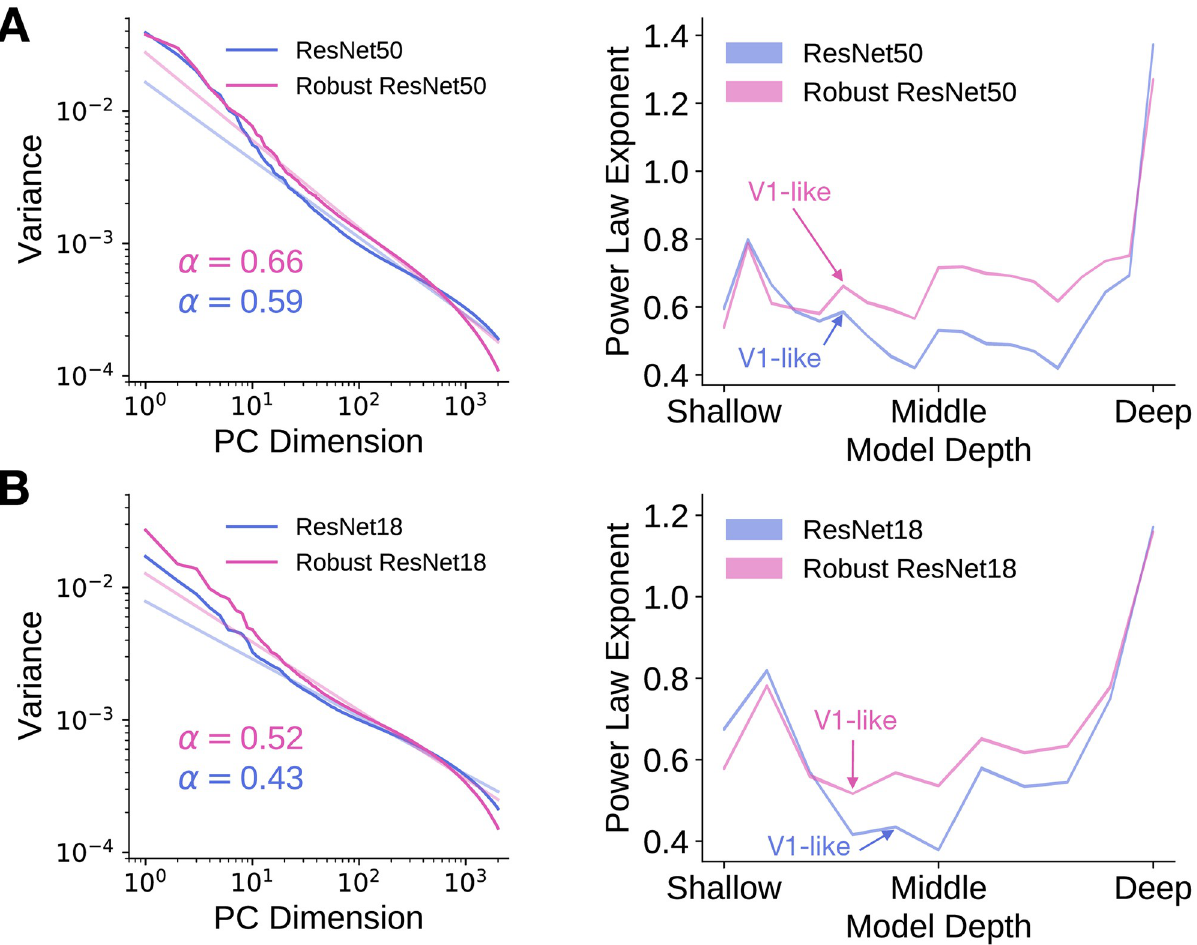
Fig 3. The internal representations of robust models is slightly lower dimensional than those of non-robust models. The eigenspectrum of the robust model decays slightly faster than that of the non-robust model. The eigenspectrum of the artificial neural responses in each layer of a model to a random subset of 2816 ImageNet validation set images was computed using principal components analysis and the power law exponent was computed by obtaining the slope of the line of best fit to the variances within the principal component range of 10 and 999. Changing the range of variances used to compute the power law exponents to those between 1 and 1000 does not alter the relationship between the power law exponents of the robust models and those of the non-robust models (S6 Fig). A . Left: We plot the eigenspectrum for the most “V1-like” layer (as determined by neural predictivity) of a robust and a non-robust ResNet-50. Light lines are the lines of best fit to the eigenspectrum (in dark colour) in log-log space between principal component dimensions 10 and 999. The inset indicates the estimated power law exponent of the eigenspectrum. Right: Power law exponents of model layers for ResNet-50. Shaded regions (too small to be easily visible) indicate standard deviation across random ImageNet validation set subsets. B . As in A , but for ResNet-18.